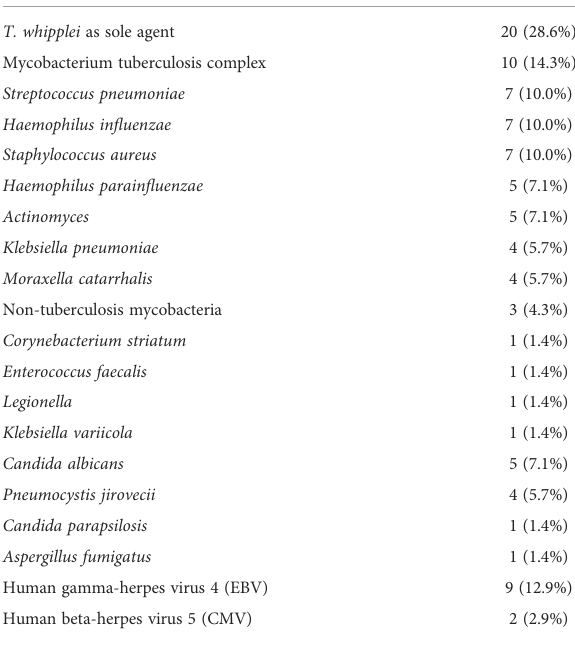
TABLE 2 Pathogen detected by